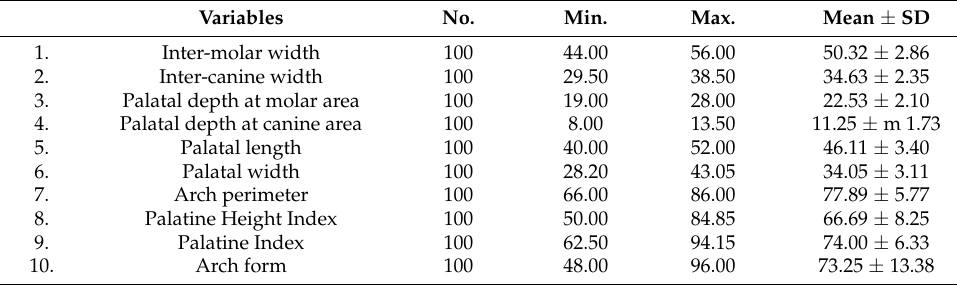
Table 1. Descriptive statistics of different variables.